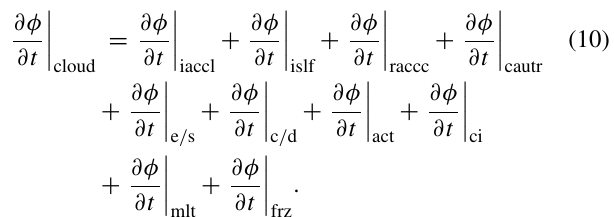
Figure 2. Flow diagram of the new scheme. The scheme is divided into three major parts: cloud processes, sedimentation and diagnos- tics. The model state is symbolized by φ as in the text. Arrows rep- resent the workflow (solid) and sub-stepping (dashed). The box la- beled vertical loop represents the part of the code that is looped ver- tically for the diagnostic treatment of rain. The parameters n in and n out refer to the number of iterations of the inner and outer loop, respectively. The red numbers on the left represent the approximate computation times of the respective parts in arbitrary units. Fig. 2. The cloud process tendency is given